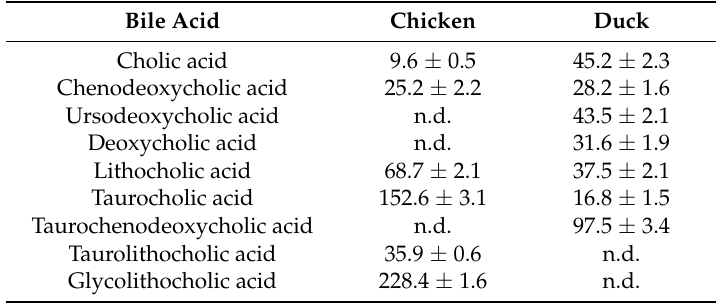
Table 2. Concentration of bile acids in the bile of the chicken and duck